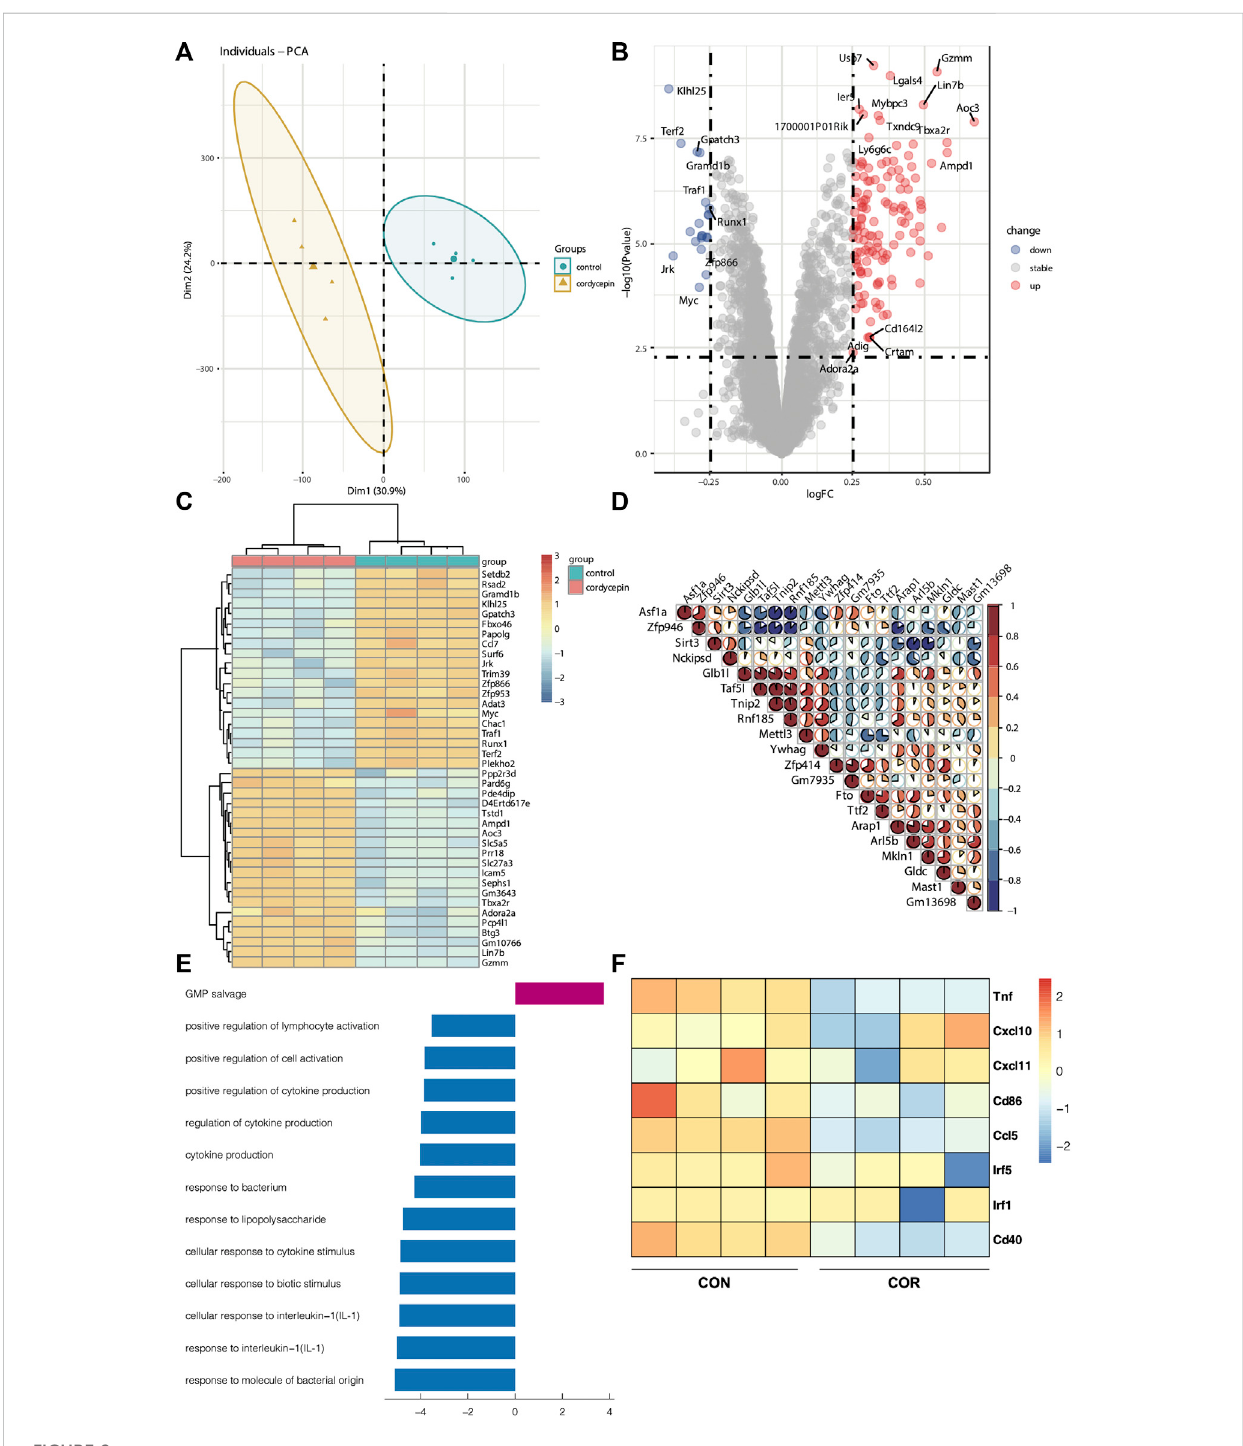
FIGURE 2 Cordycepin decreases the function of macrophage I (M1 macrophages) (A) . PCA showed the difference between the two groups (B) . DEGs of two groups. The marked genes by tags were those with a p -value < 0.005 and a log Fc > 0.25 (C) . Heatmap was chosen to show the top 20 up- and downregulated genes (D) . Heatmap was chosen to show the correlations of the top 20 genes (E) . KEGG pathway enrichment analysis was performed utilizing the KEGG pathway database (http://www.genome.jp/kegg). Based on the function of macrophages, the pathways were selected. The decreasingfunctionisrepresentedbythebargraphs(blue),andtheincreasingfunctionisrepresentedbythebargraphs(red) (F) .Heatmapwaschosento show the differential gene expression of molecular markers of the M1 phenotype. Cordycepin was represented by “ COR ”